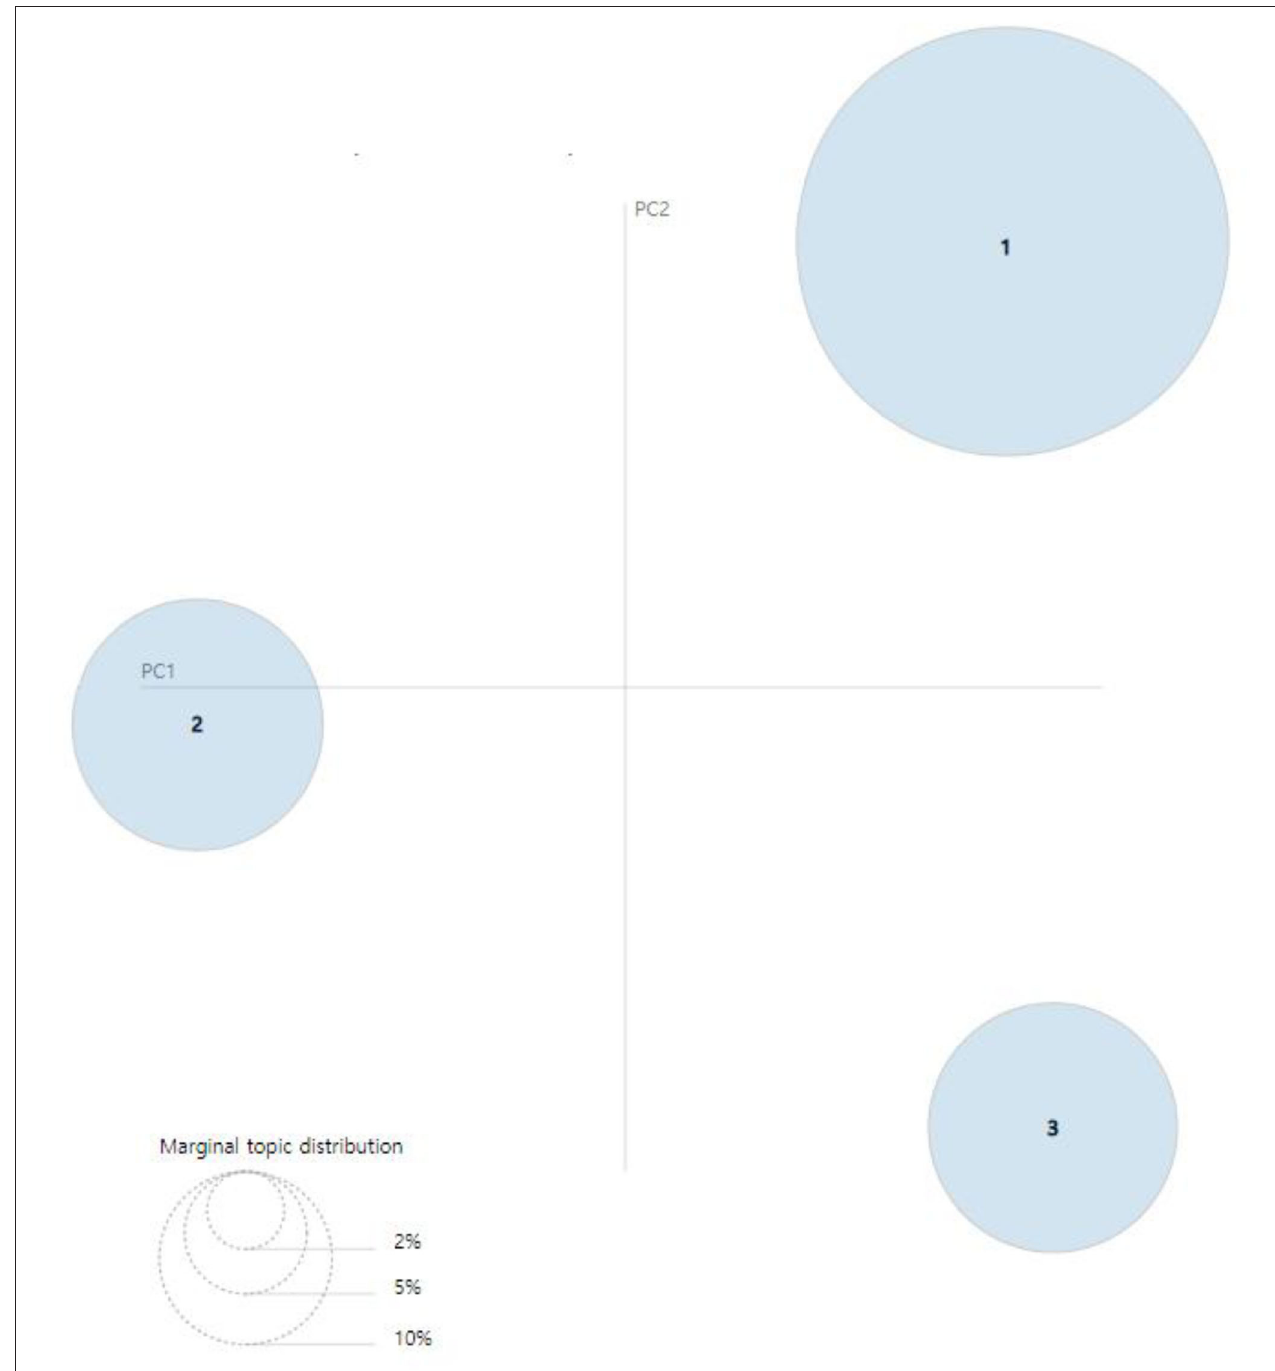
FIGURE 8 | Visualization results of inter-topic distance map via multidimensional scaling (MDS) (2007–2009)